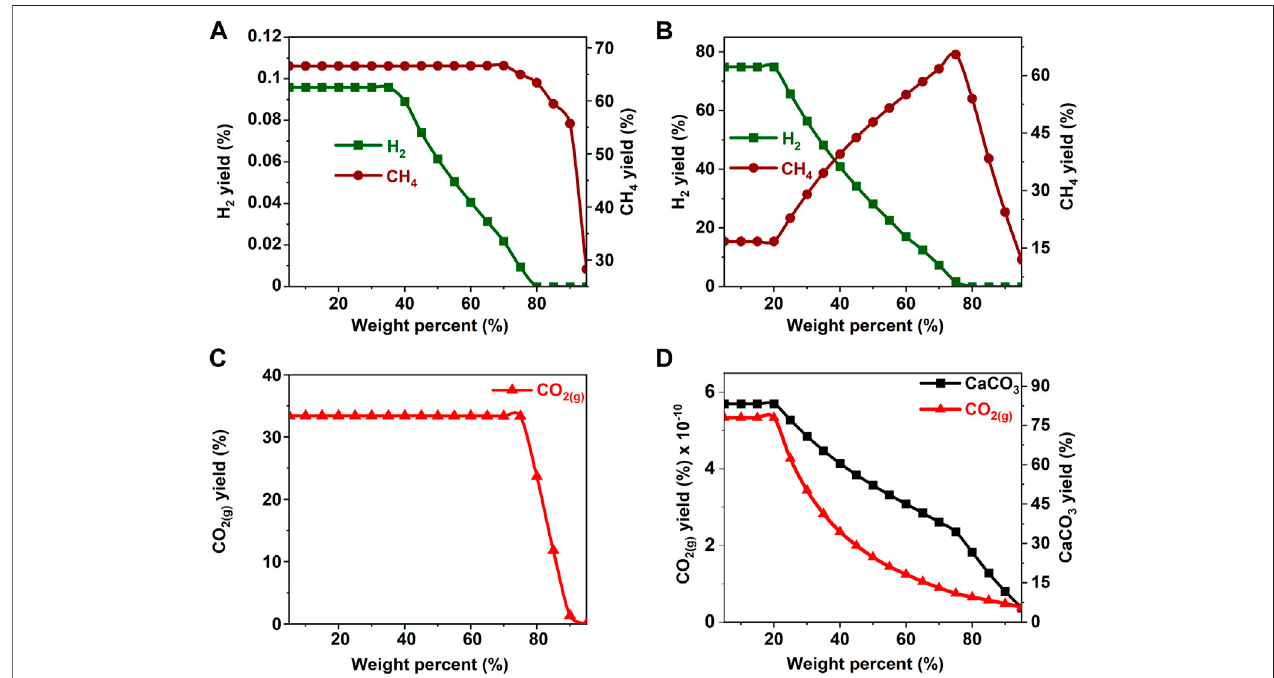
FIGURE 7 | Effect of acetone concentration on the product yield (A , C) in the absence and (B) in the presence of calcium oxide. The yield of CO 2 post capture to produce calcium carbonate is represented in 5 (D) . These calculations are performed with temperatures of 227 ° C and pressures of 50 bar.